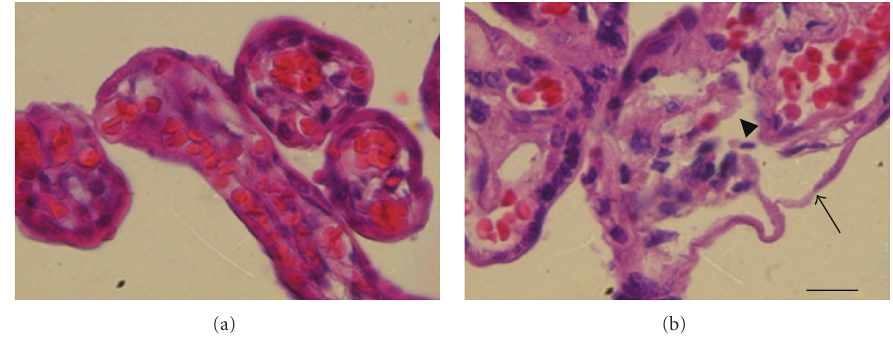
Figure 3: Histopathological analysis of placentas from mothers infected with T. cruzi . Chorionic villi from T. cruzi -infected placentas (b) show severe tissue damage compared to control villi from healthy noninfected woman (a). Detachment and disorganization of the syncytiotrophoblast (arrow) as well as fetal connective tissue destruction of the villous stroma (arrowhead) is observed. Chorionic villi were processed for routine histological techniques and stained with hematoxylin-eosin. Bar scale: 25 μ